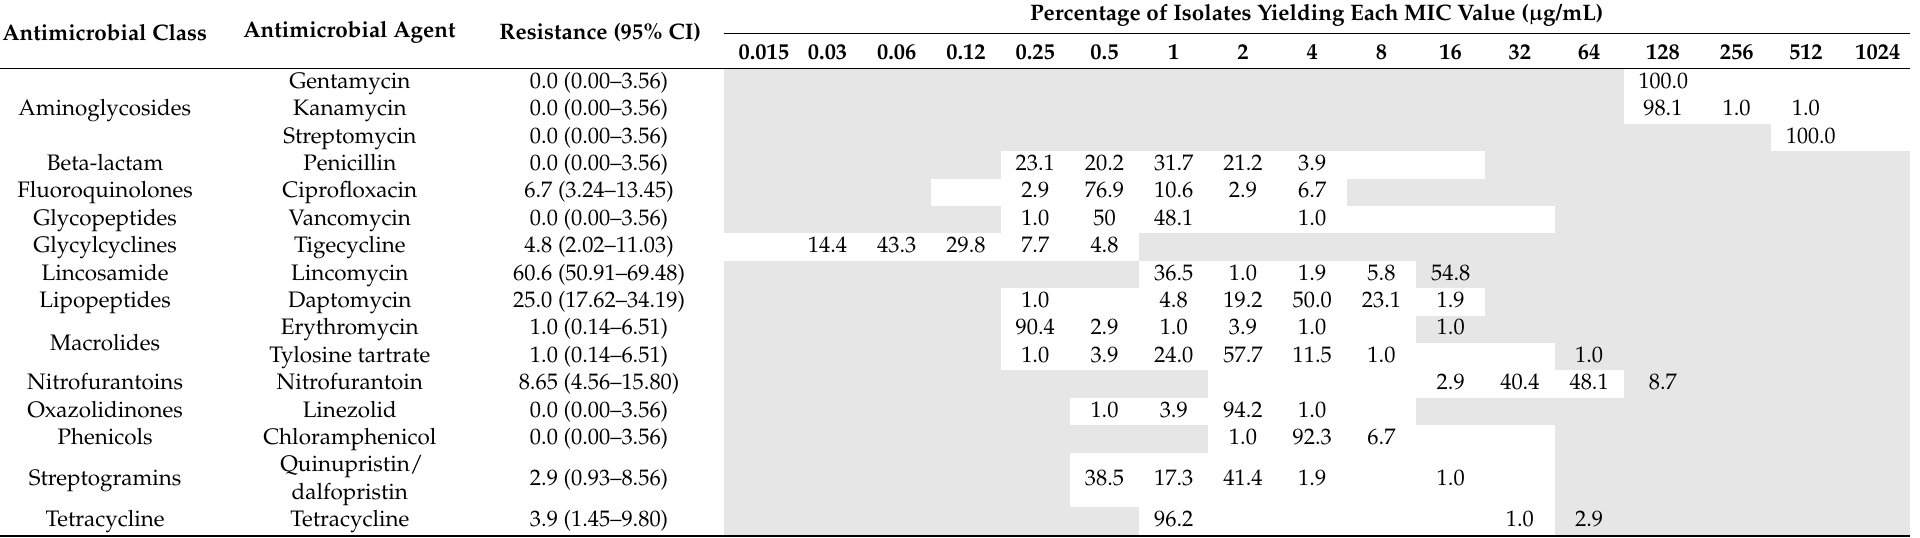
Table 2. Antimicrobial ( n = 16) minimum inhibitory concentration (MIC) distribution data obtained for 104 Enterococcus spp. isolated from 150 rectal faecal samples at feedlot entry ( n = 104). The vertical line within each MIC distribution indicates the resistance breakpoint (see Table 1) for each antimicrobial except for tigecycline, where it indicates the susceptible